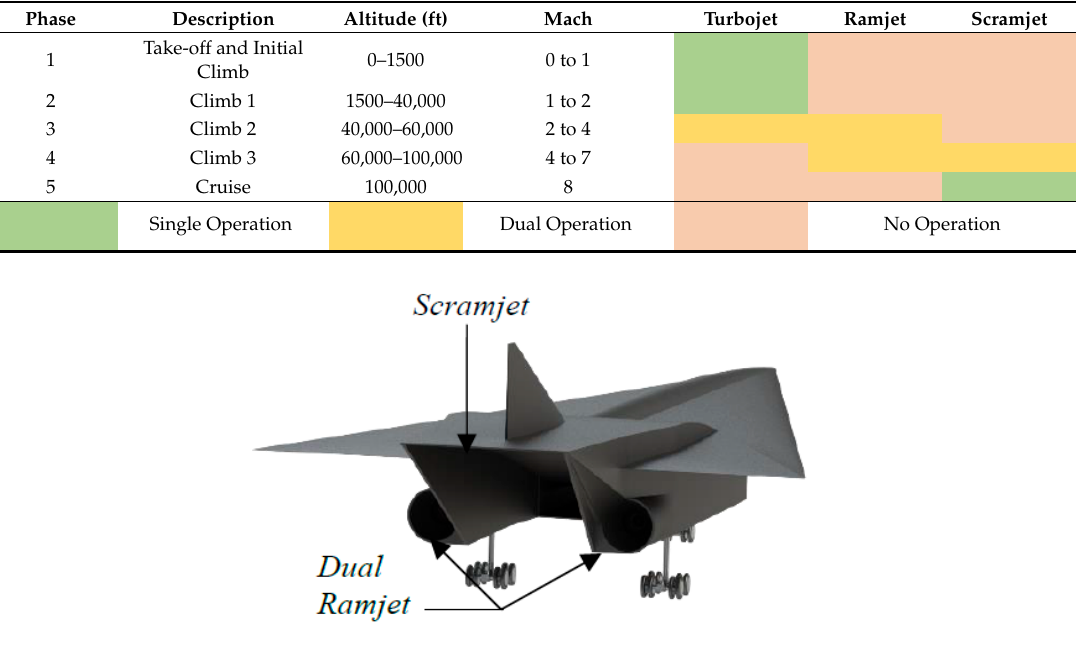
Figure 7. Concept hypersonic aircraft.